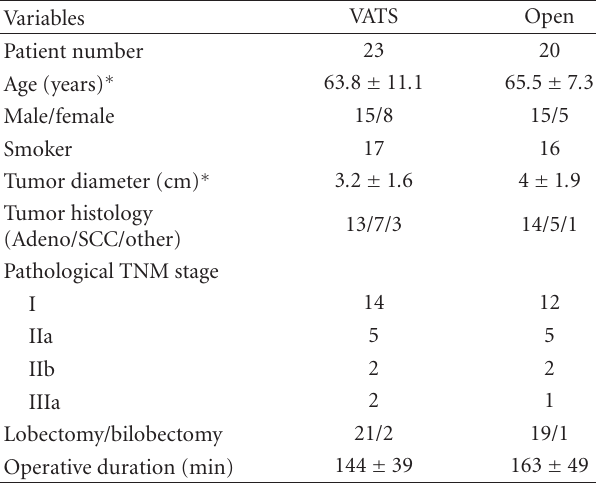
Table 1: Clinical